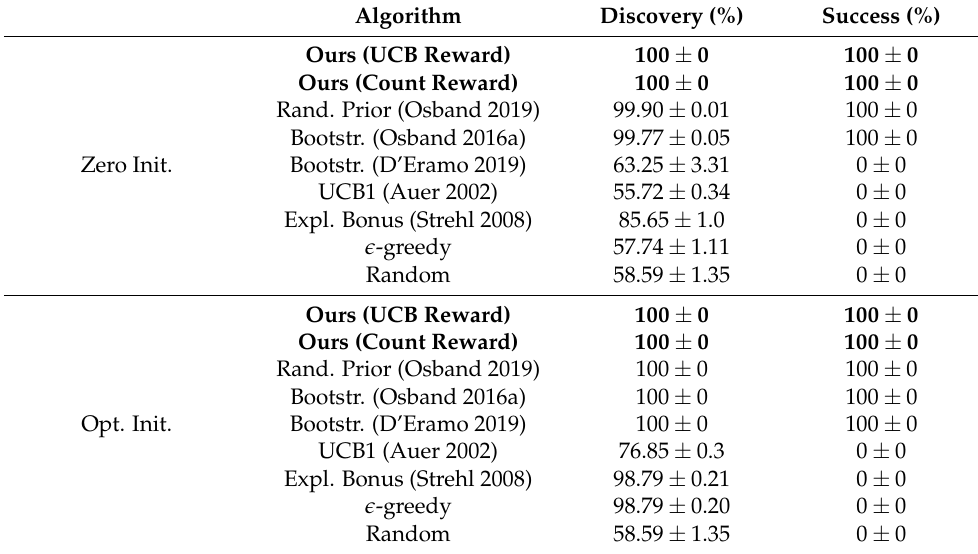
Table A2. Deep sea results